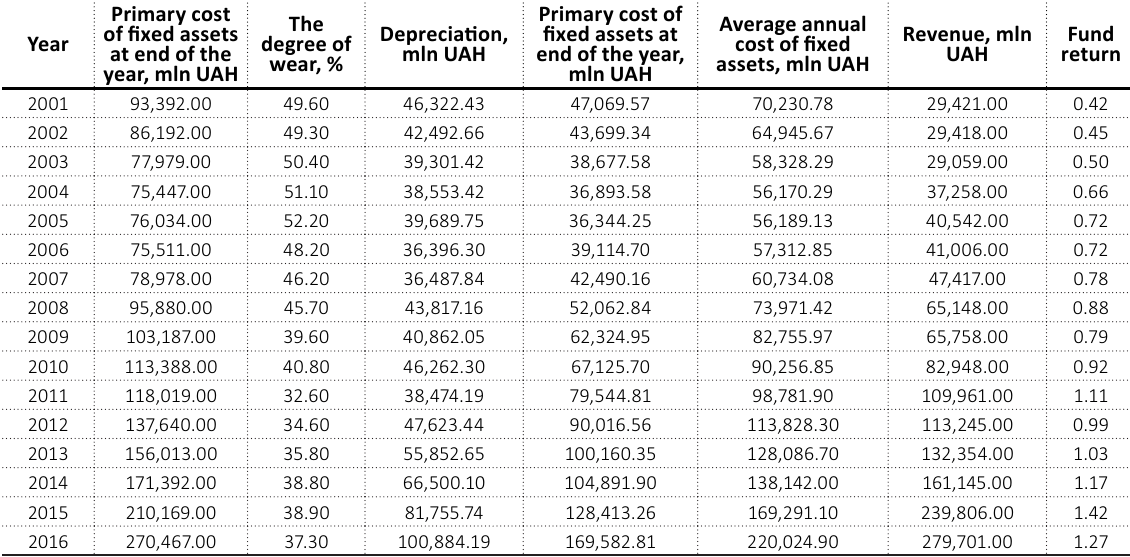
Table 1. Key indexes of the agricultural industry for the study Source: Authors’ calculations based on State Statistics Service of Ukraine (2011, 2016, 2018).